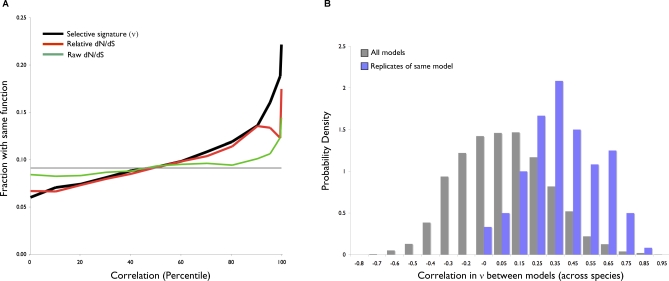
Selection Acts Coherently on Cellular Functions(A) Correlations in ν, dN/dS, and relative dN/dS (normalized as described in Methods) were obtained for the 109,405 gene-pairs with a COG functional category annotation (16 categories, excluding “general” or “unknown” function). Of these pairs, 10,377 have the same COG function, accounting for a proportion of ∼0.09 of the total (plotted as a solid gray line). Pairs were binned according to correlation-percentile in groups of ten percentile points except for the last three (90%–95%, 95%–99%, 99%–100%). Shown is the fraction with common function in each bin. To avoid potential bias, percentiles were calculated separately for genes present in different numbers of species (15 bins ranging from 16 to 30 species).(B) Gene families under the same model of evolution have highly correlated selective signatures. Correlations in ν were obtained for all pairs of simulated gene families, with or without branch variation in dN/dS, and with dN/dS chosen randomly from within ±1 standard deviation of the mean of the observed dN/dS values (range: 0.005–0.26). The distribution of correlations is shown for pairs of gene families with branch variation in dN/dS and that are replicates of the same evolutionary model (light blue). The distribution of all pairwise correlations—including gene families with or without branch variation, and pairs from the same or different models—is also shown (gray).